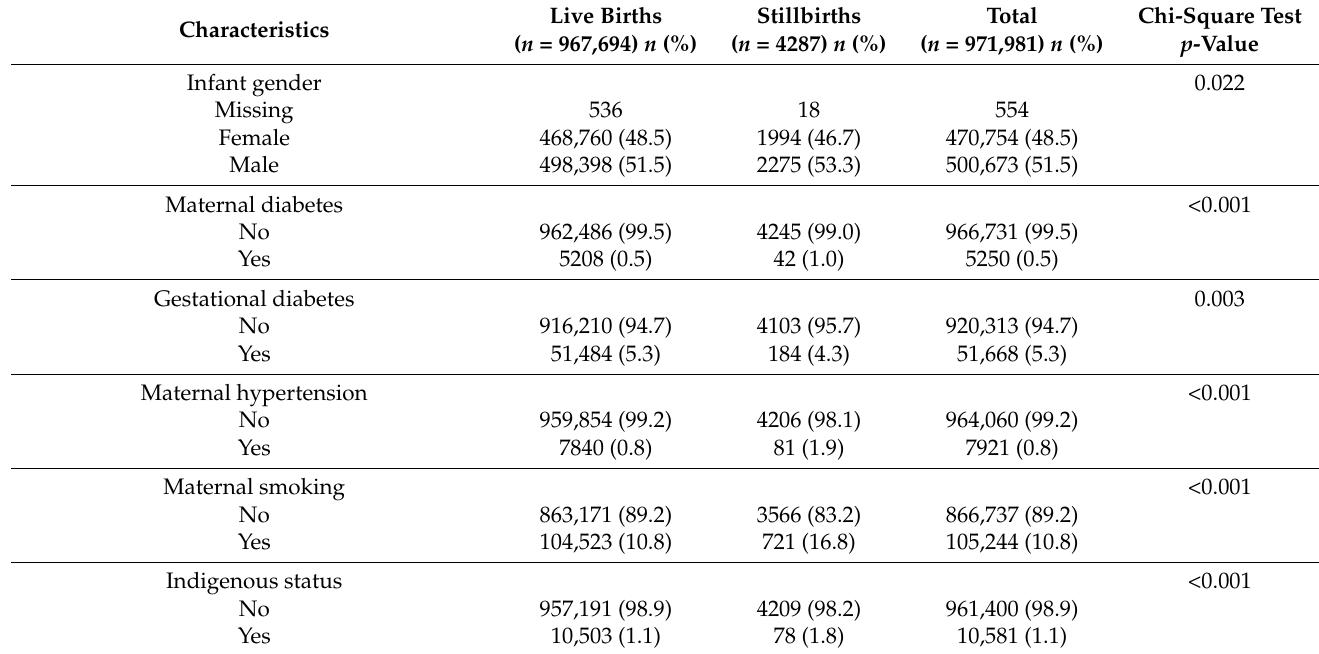
Table 1. Characteristics of live births and stillbirths, Sydney, Australia, 1997–2012.